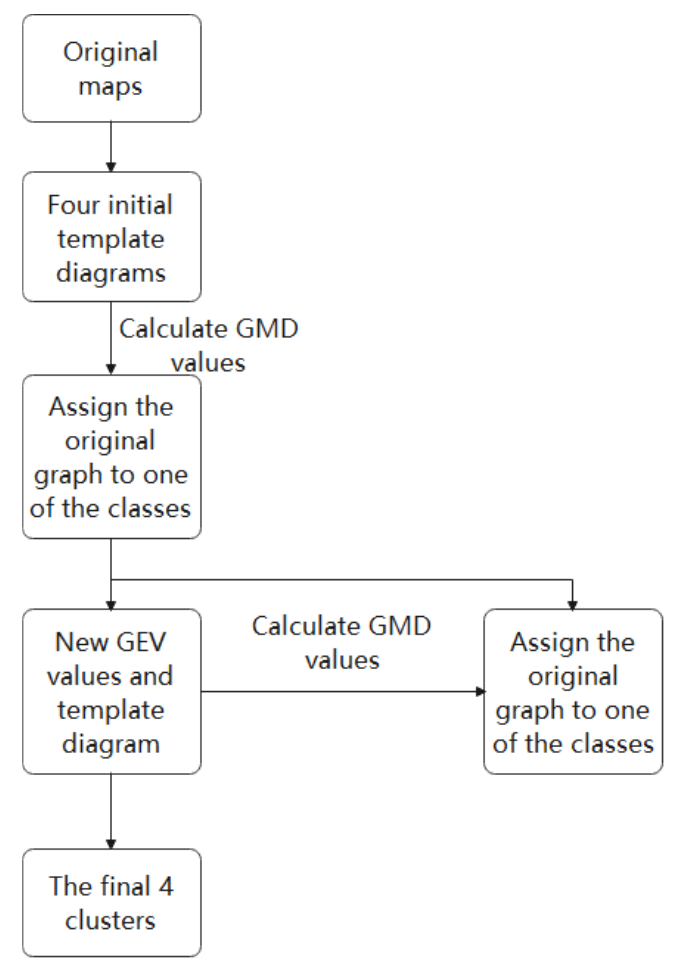
Figure 3. Microstate category recognition process based on K-means clustering. In the formula, 𝑢 (cid:3036) represents the voltage value of the first topographic map, 𝑣 (cid:3036) rep- resents the voltage value of the second topographic map, and 𝑁 refers to the number of electrodes. The range of GMD values is from 0 to 2. Zero means that the two maps are completely consistent, and two represents the polarities of the two maps on the contrary. The algorithm of K-means clustering comes from the research of Koening et al. [12]. For each model topographic map, we will obtain a time series of spatial correlation coeffi- cients, and for each original topographic map, we can obtain a model topographic map figure with the lowest GMD. Based on these results, we calculated the overall proportion of variance explained (GEV, which describes the proportion of variance explained by the model topographic map over all original topographic maps) for the four selected model topographic maps. We matched the model topographic map with the original topographic map based on the GMD value, marked the original map as the type with the smallest GMD, and superimposed all the original topographic maps marked with the same model topographic map to obtain four new topographic patterns. (4) We repeated step 3 until the GEV value did not increase (i.e., the GEV reached the highest level), and the final four- mode topographic map is obtained. The original scalp potential topography obtained by each subject at each time was compared and matched with the microstate (pattern topo- graphic map) obtained by clustering, the four microstates were marked as A, B, C, and D, and the subjects were obtained. The corresponding EEG microstate time series parameters